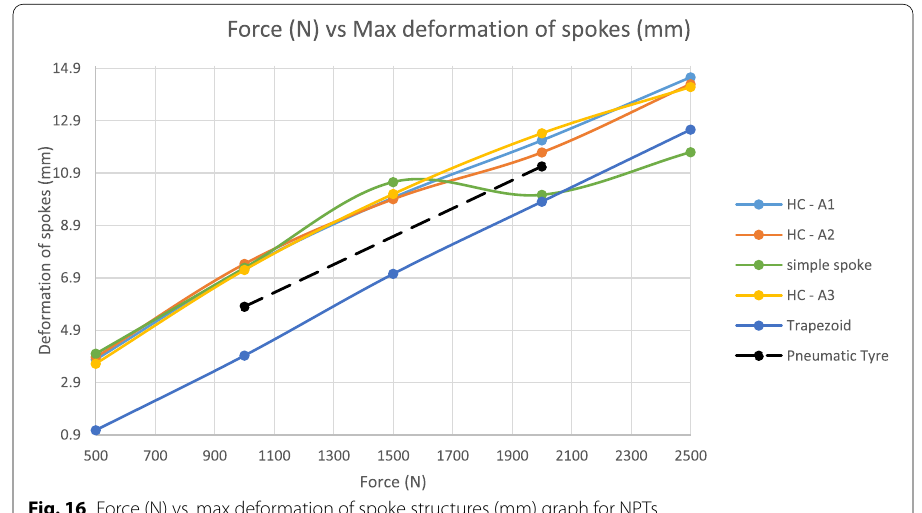
Fig. 16 Force (N) vs. max deformation of spoke structures (mm) graph for